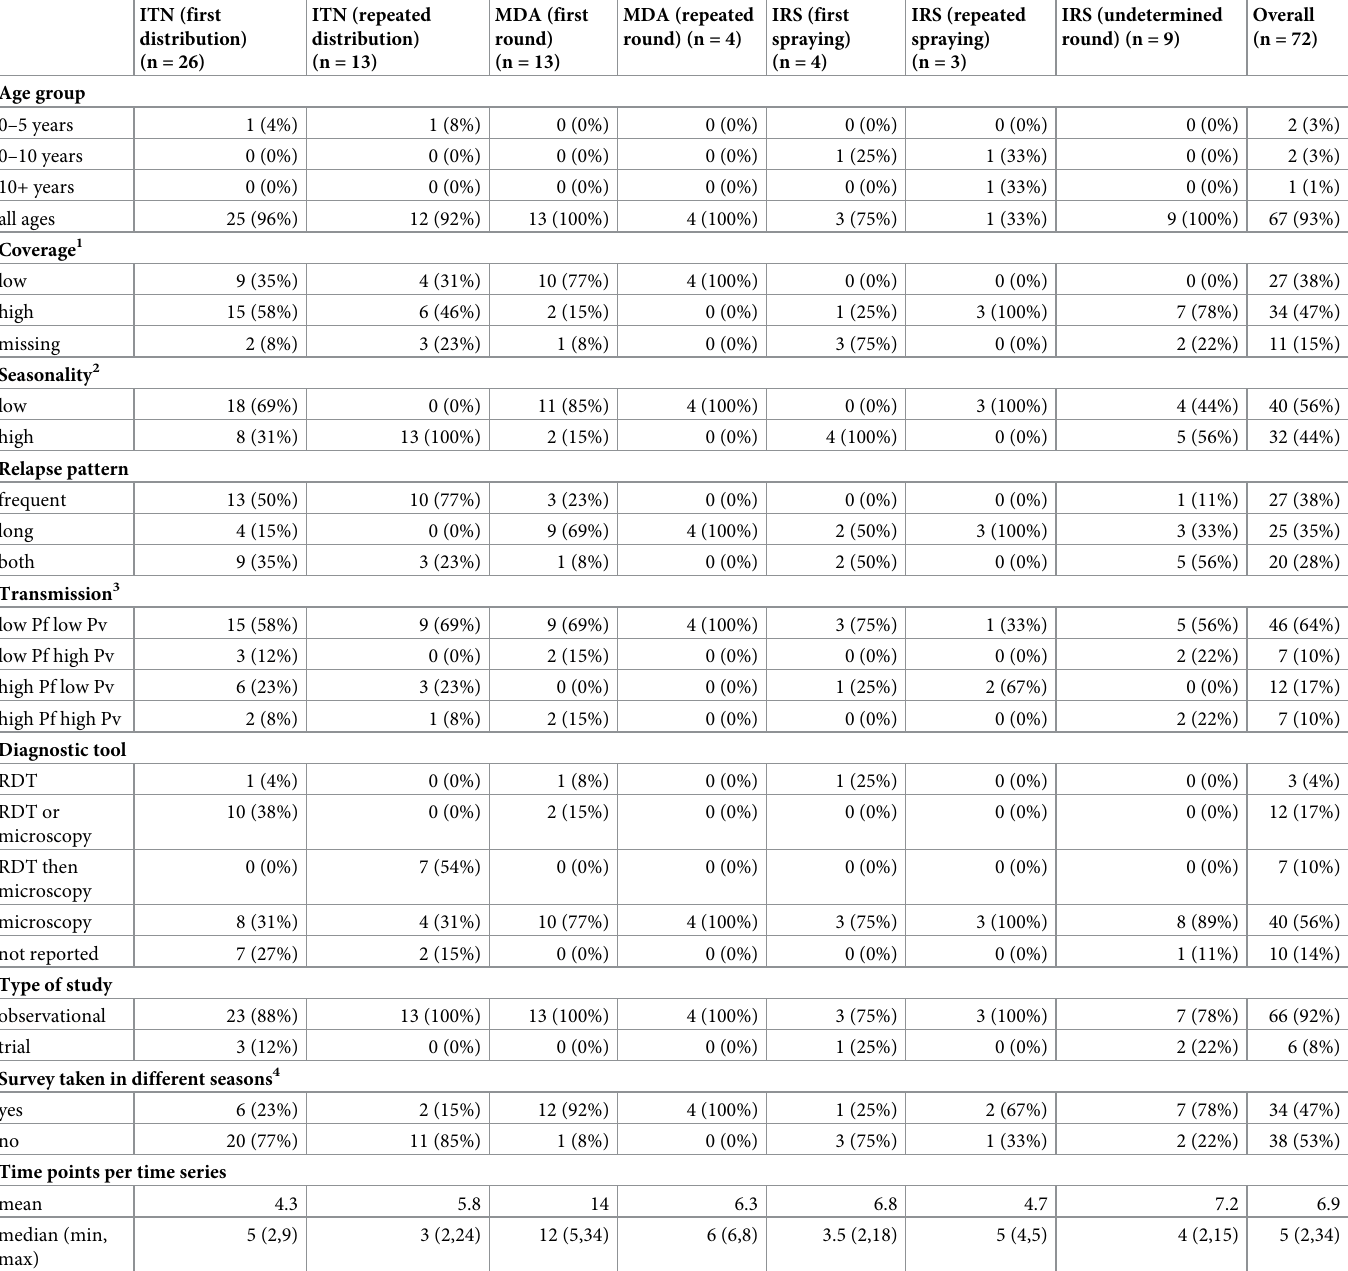
Table 2. Characteristics of the 72 series of time-points of clinical cases by